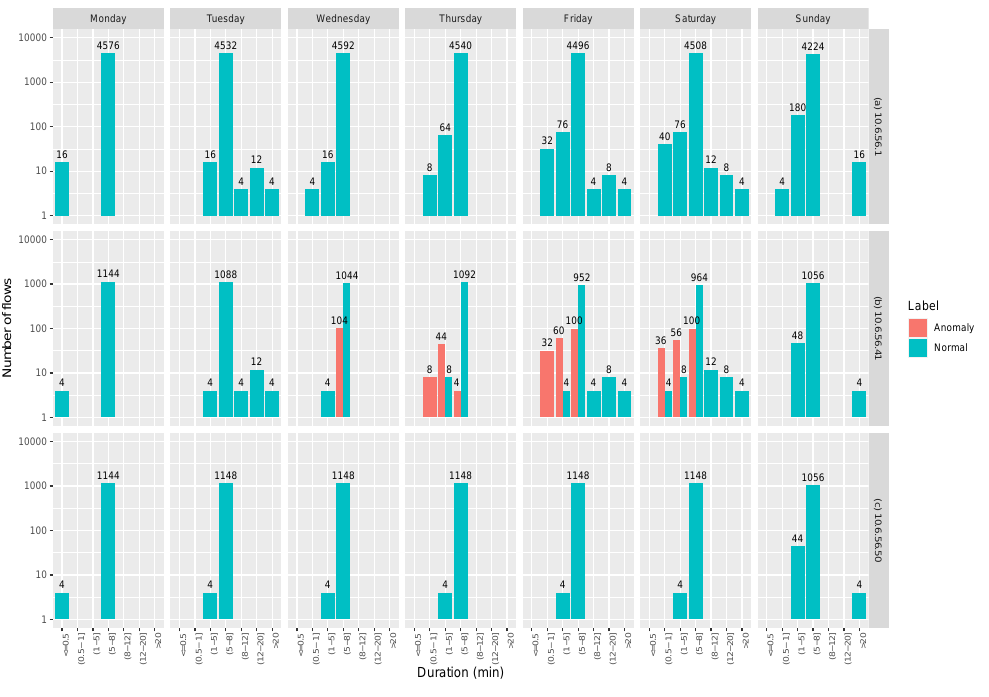
Figure 11. Log-linear duration of lag between flows. ( a ) Broker. ( b ) An abnormal node. ( c ) A normal